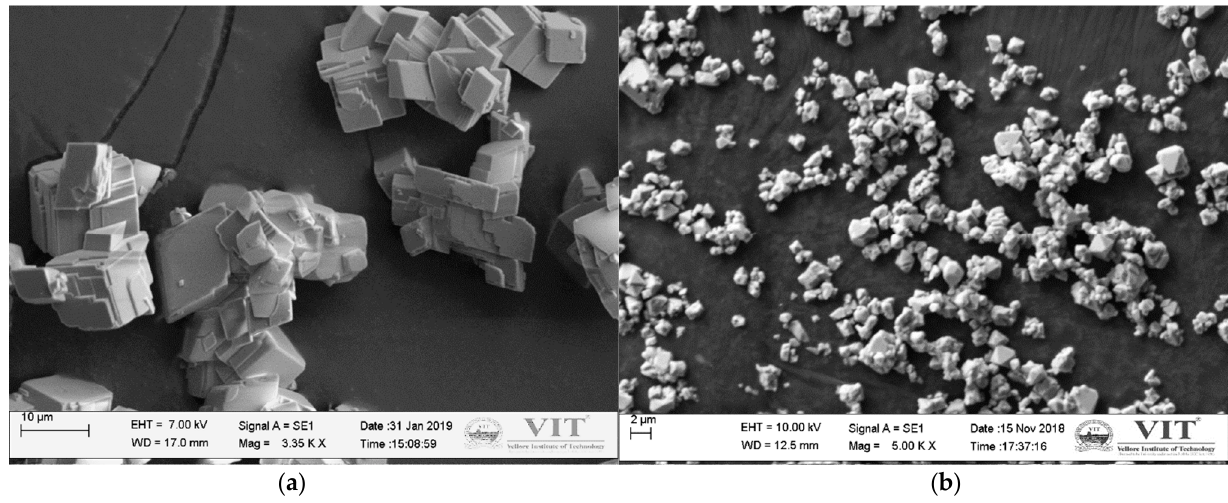
Figure 1. SEM images of the precursors ( a ) calcium carbonate and ( b ) cobalt